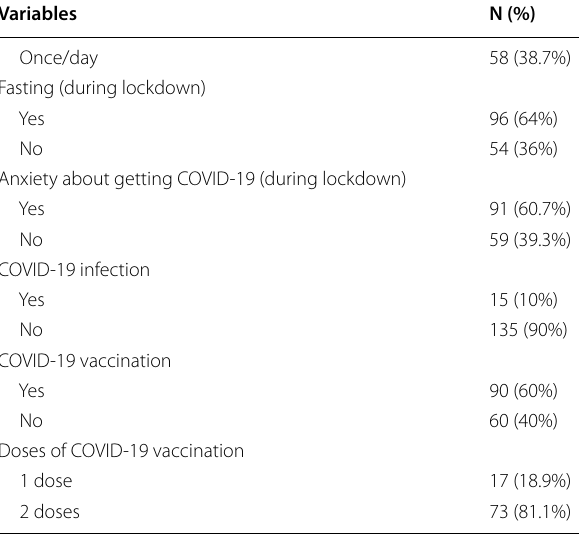
Table 2 HbA1c mean